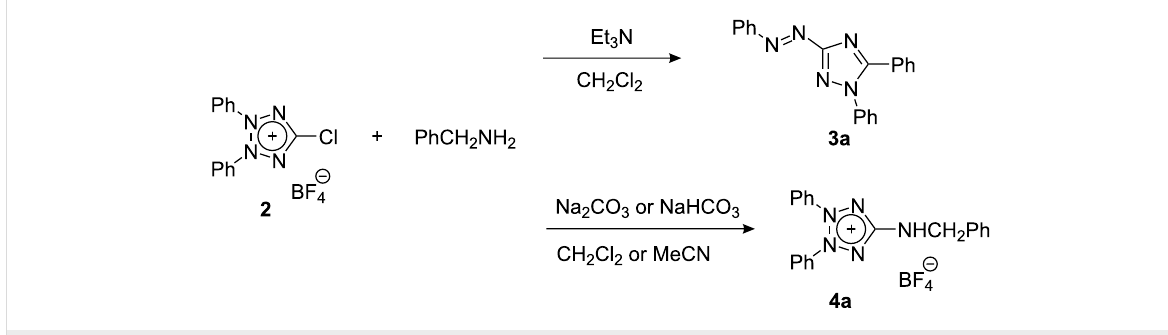
Scheme 1: Reaction of chlorotetrazolium 2 with benzylamine.